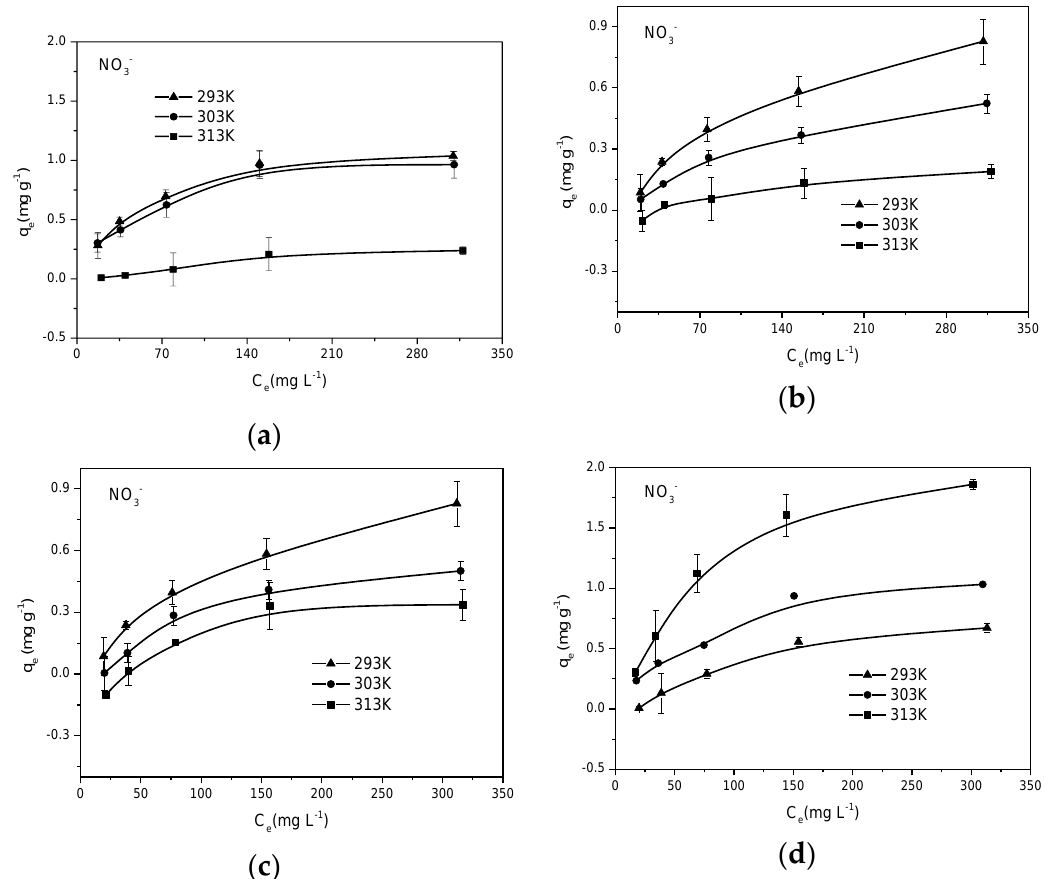
Figure 5. Amount of NO 3− on RSB500 ( a ), PCB300 ( b ), SDB500 ( c ) and ESB300 ( d ) under different temperature, respectively. Data are means ± SD of n = 3. Table 6. Thermodynamic parameters for P and NO 3− adsorption.